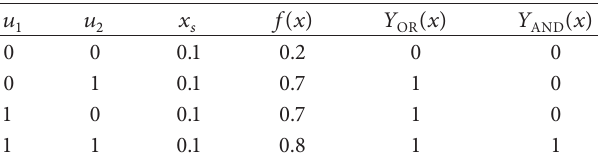
Table 2: Outputs for the logical functions 𝑓 14 and 𝑓 8 (OR and AND logical